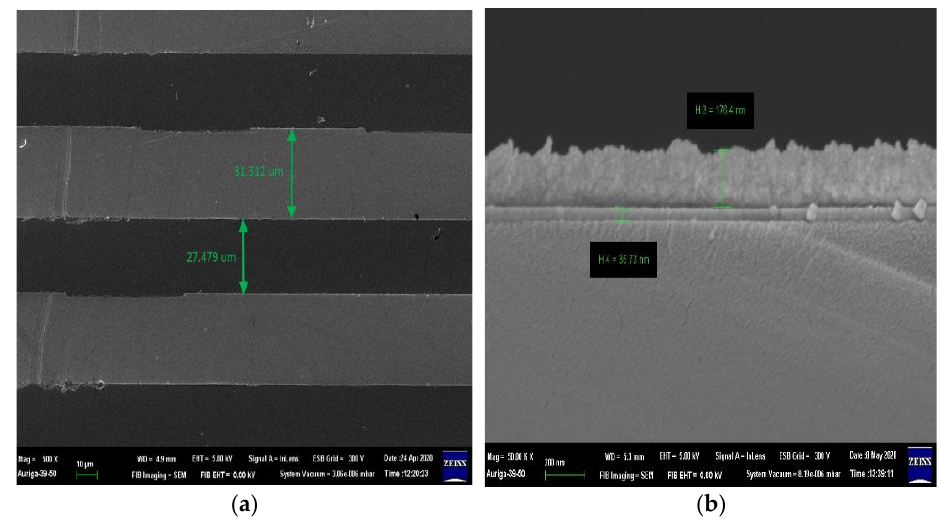
Figure 2. SEM images of the IDμE sensor. ( a ) Top plane, ( b ) side tomography. A thin layer of titanium (Ti) was sputtered on to a Silic substrate to serve as an adhesive layer for the gold (Au) layer. The ratio between Ti:Au was set to a standard 1:3 ratio. An SEM image was also taken to confirm the thickness (Figure 2b).